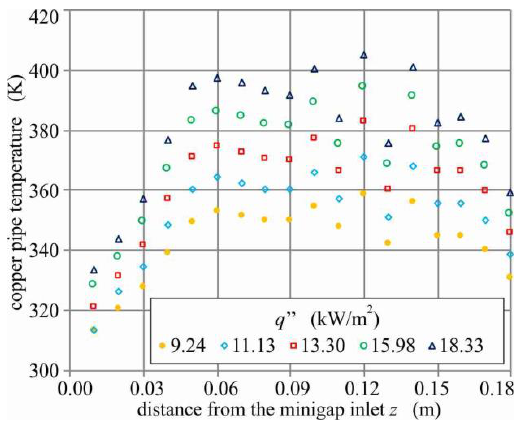
Figure 4. Copper pipe temperature obtained with the use of 18 K-type thermocouples.